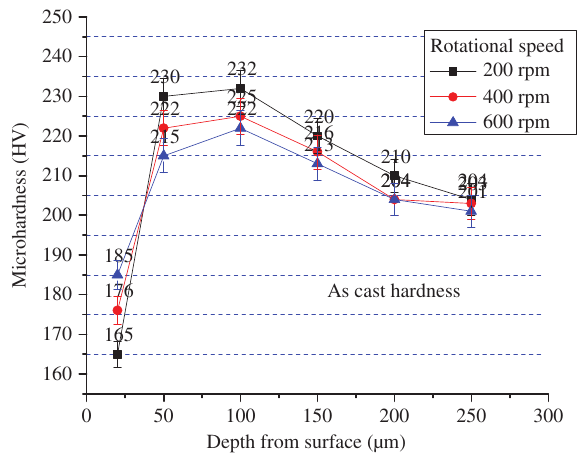
Figure 13: Microhardness vs. depth of